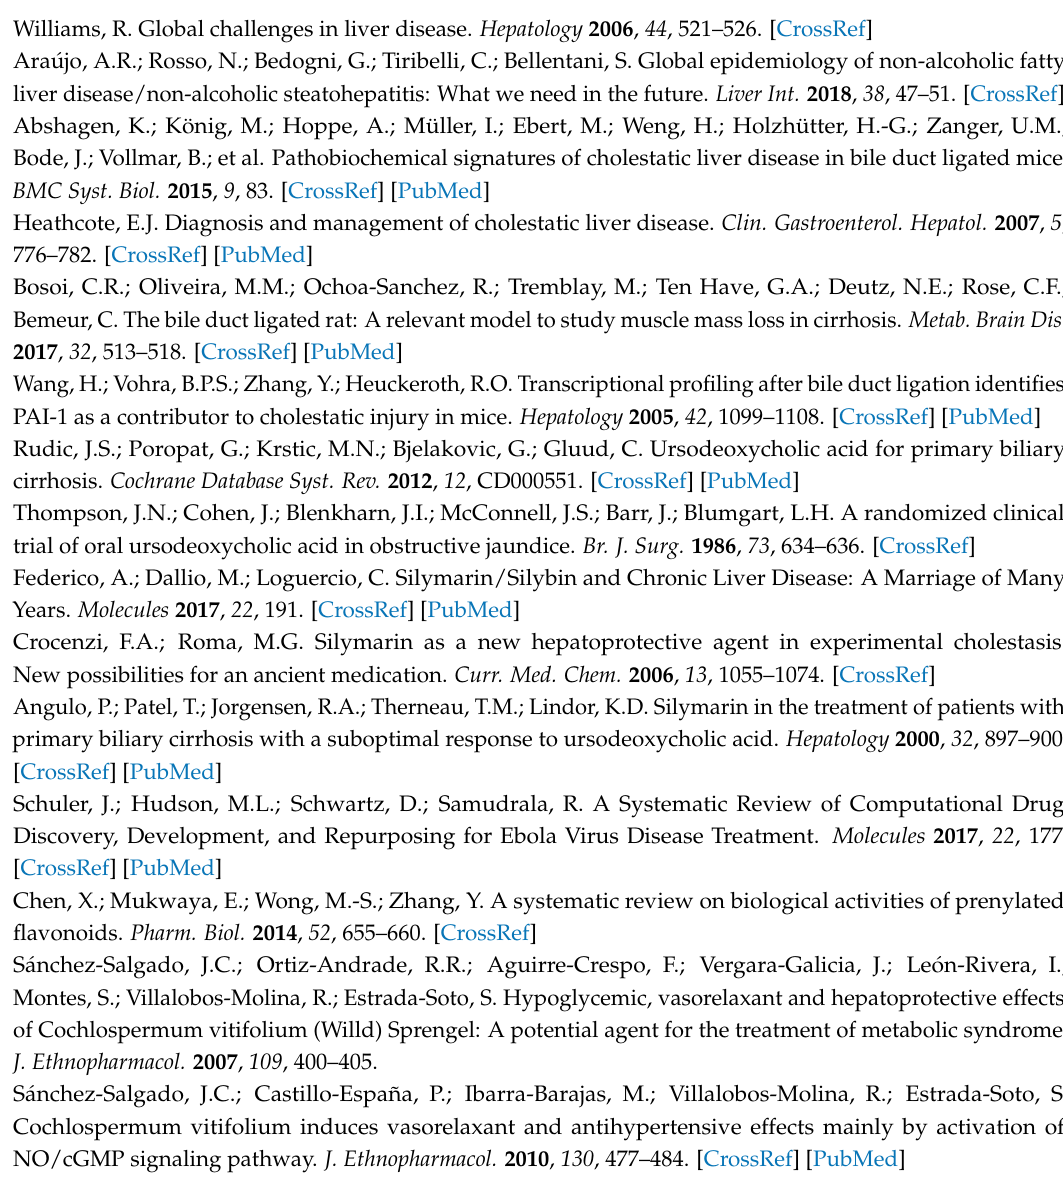
Figure S1: SYRCLE’s tool for assessing risk of bias of the selected studies, Table S1: PICO strategy developed for systematic